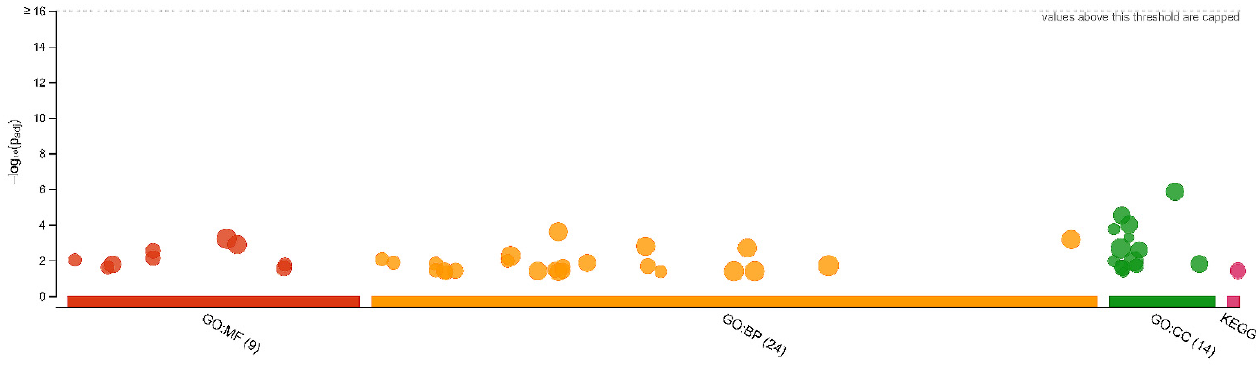
Figure 2. The g:Profiler analysis of differentially regulated proteins (DRPs). Manhattan plot that illustrates the enrichment analysis results. The functional terms are grouped and color-coded by data sources, i.e., molecular function (MF) are red, biological processes (BP) are orange, cellular components (CC) are green, and Kyoto Encyclopedia of Genes and Genomes (KEGG) are pink.